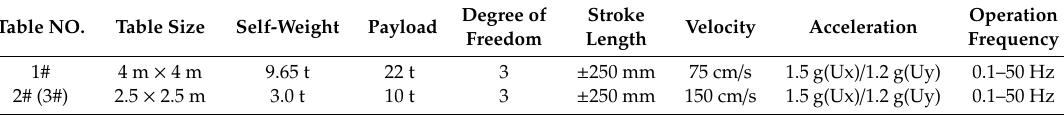
Figure 2. Shake tables system of Fuzhou University. Table 1. Performance specifications of the shake tables system.